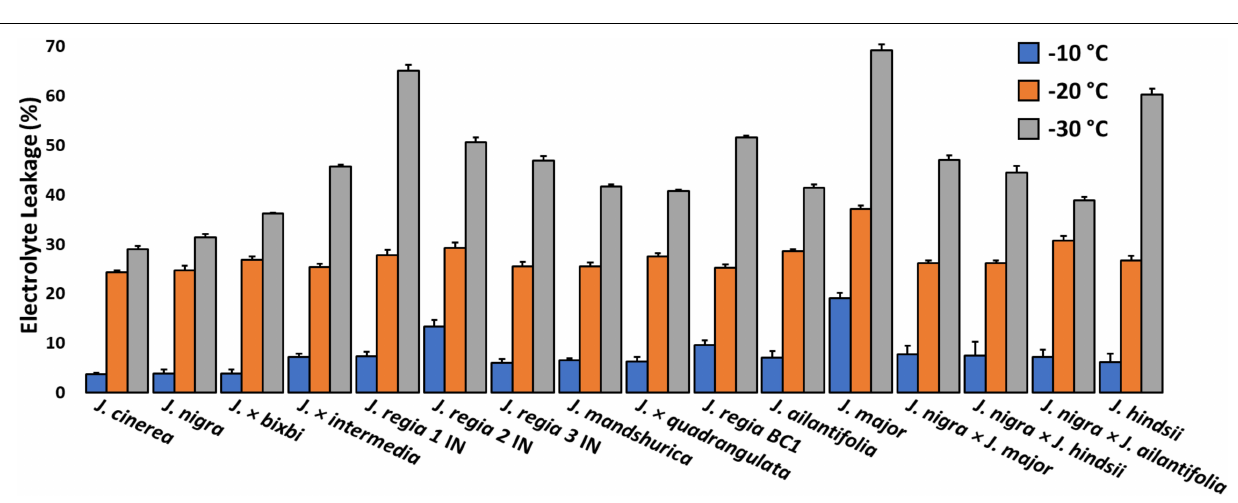
FIGURE 3 | Index of freezing damage for 1-year-old twigs from Juglans species. and interspecific hybrids at –10, –20, and –30 ◦ C. Damage indices (D i ) were obtained following protocols published by Earnshaw (1993). All J. regia used for electrolyte leakage analysis were obtained from Indiana and J. regia from California was excluded from this analysis. J. major was obtained from